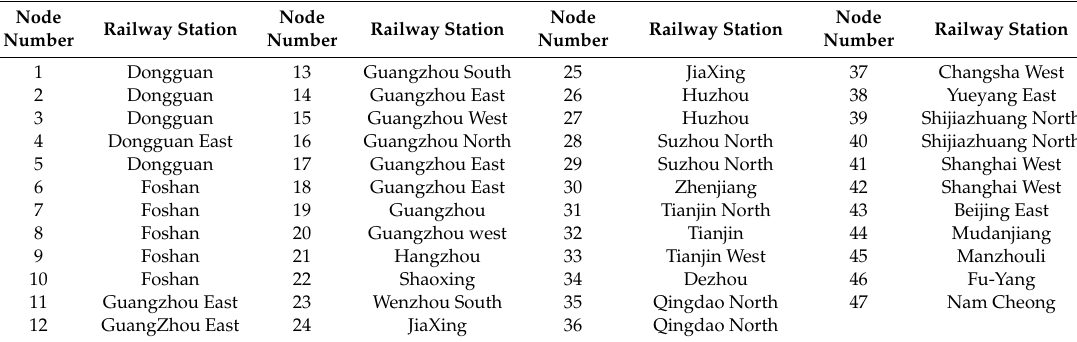
Table 7. Railway transportation conditions in 47 timber markets.